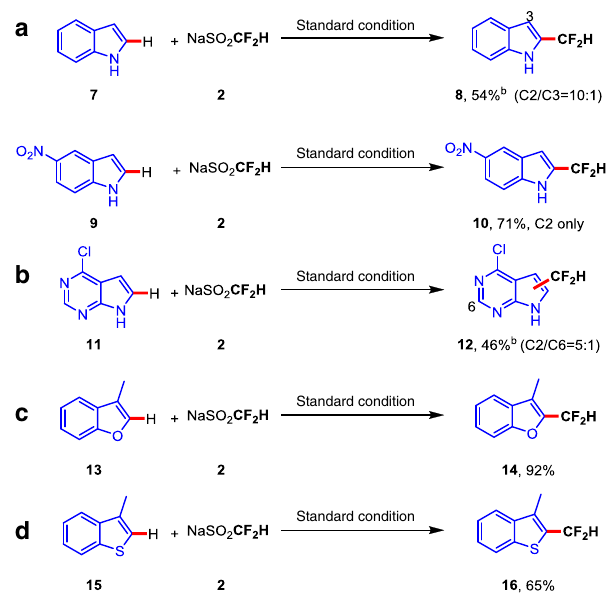
Fig. 5 Site-selectivity study. a Regioselectivity for indoles. b Regioselectivity for 4-chloro-7H-pyrrolo[2,3-d] pyrimidine. c Regioselectivity for benzofuran. d Regioselectivity for thianaphthene. Reaction conditions: heterocycles (0.1 mmol), CF 2 HSO 2 Na 2 (0.4 mmol), rose bengal (5 mol%) in 1 mL DMSO under two 3 W green LEDs irradiation at room temperature. Isolated yields based on heterocycles. b The minor regioisomeric position is labeled with the respective carbon atom